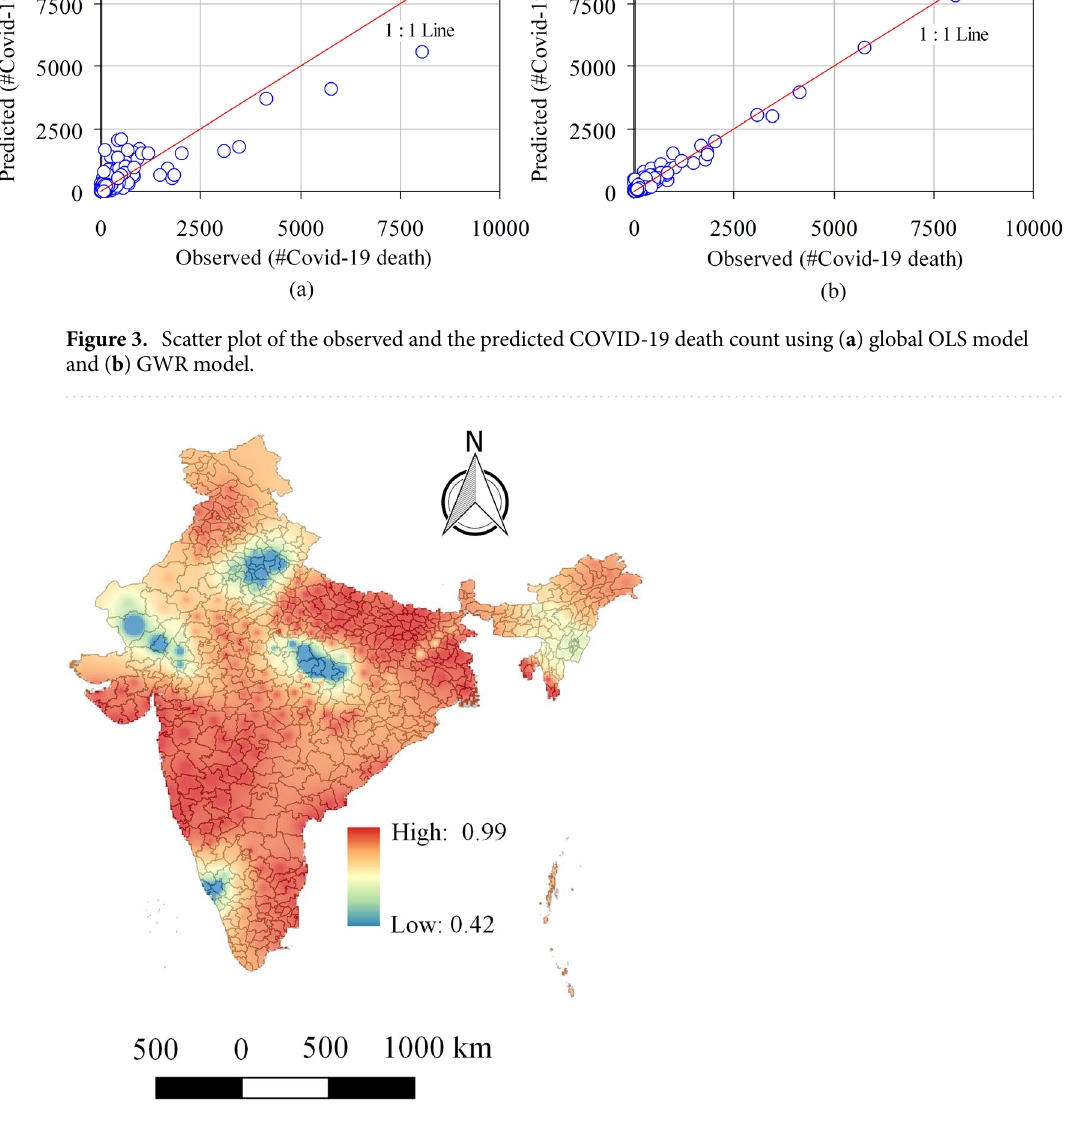
Figure 4. Geographical distribution of R 2 values for geographically weighted regression (GWR)